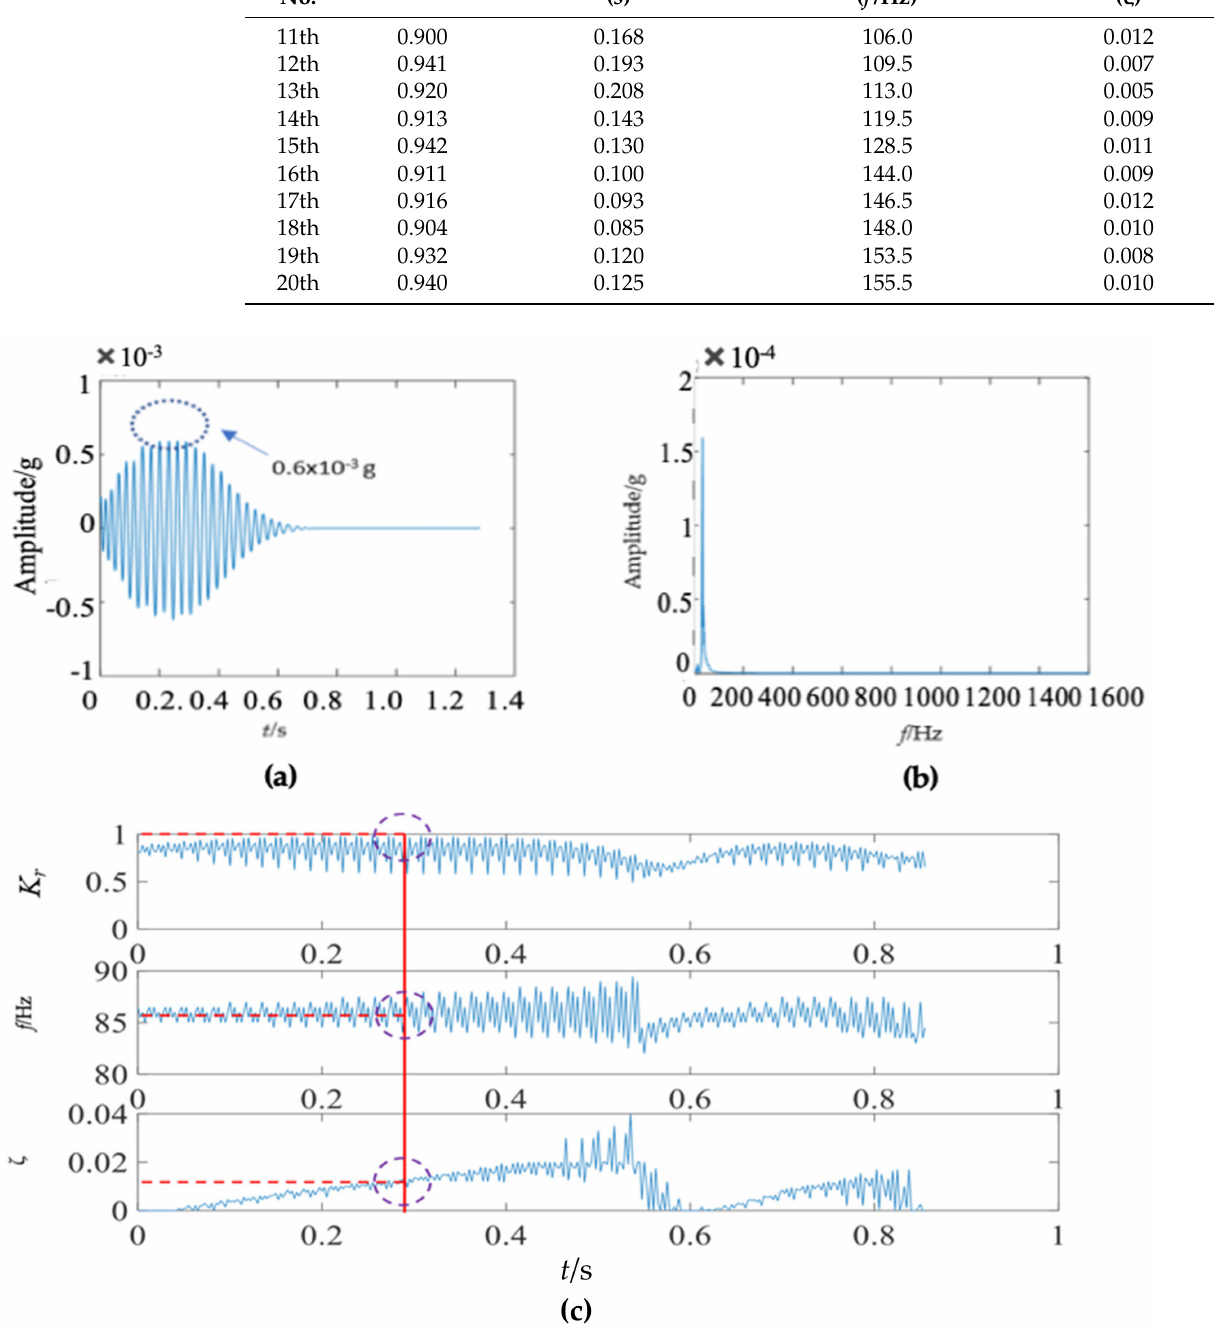
Figure 17. First mode in the vibration response signal of the wooden utility pole labeled as 265173: ( a ) the vibration response of the first mode in the time domain, ( b ) the frequency spectrum of the first mode, and ( c ) the results of Laplace wavelet correlation filtering of the first